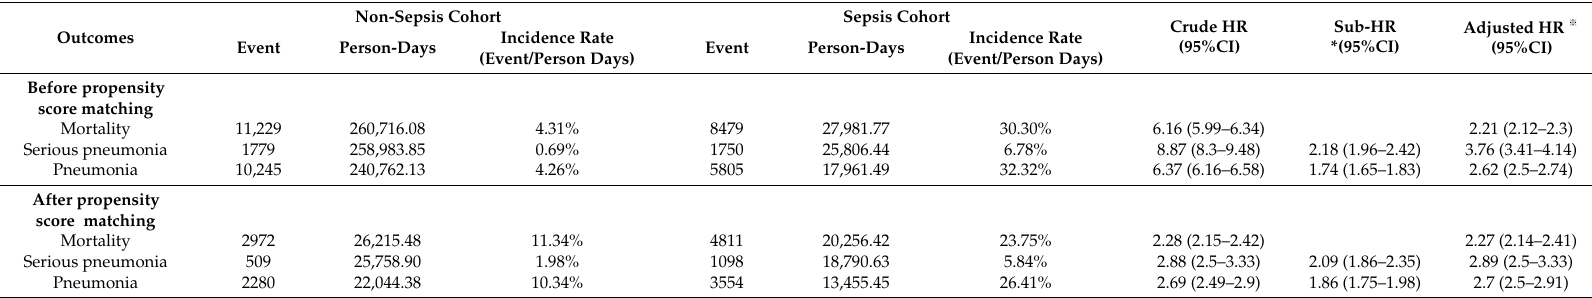
Table 3. Incidence rates and risks of pneumonia, serious pneumonia of COPD patients comparing between sepsis and non-sepsis cohort before and after propensity score matching.